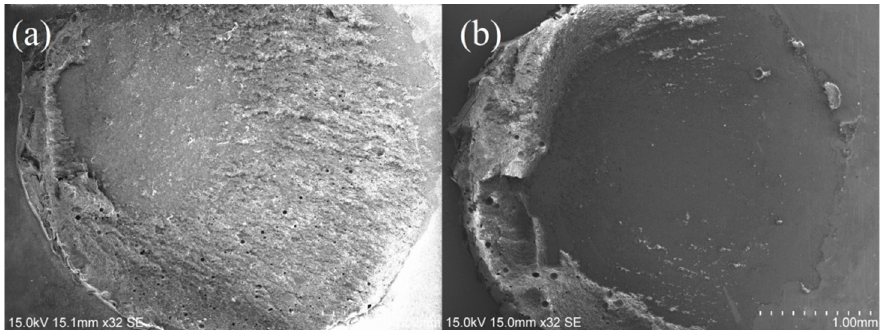
Figure 3. SEM micrographs representing the debonded areas of mixed failure on ( a ) TSC and adhesive failure on ( b ) PVD-coated zirconia samples at 32× magnification.